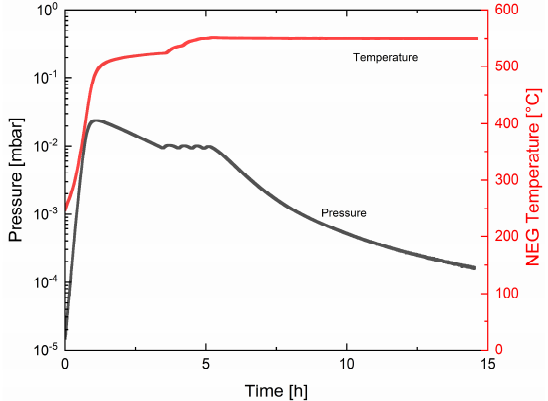
Figure 18. Typical regeneration process regarding the getter temperature and related gas release which increases the pressure inside TIMO under continuous TMP extraction.